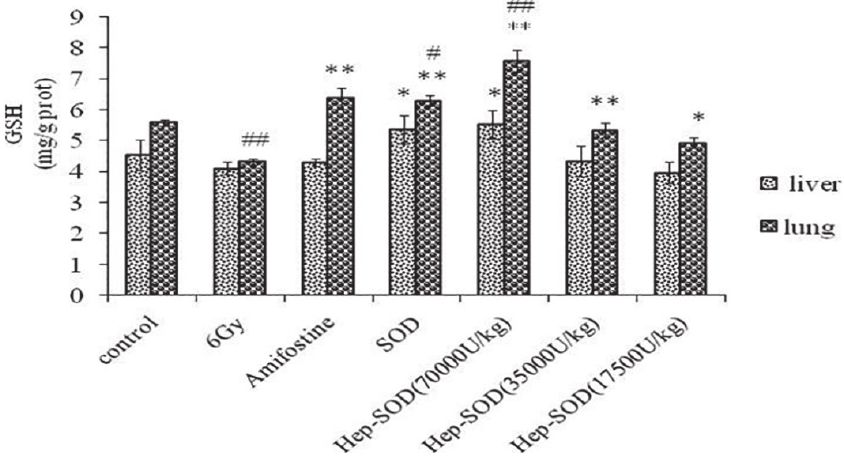
FIGURE 3 – GSH content in the liver and lung of irradiated mice in different groups. Notes: GSH content of 56 mice in different groups was detected, with eight mice in each group. * P < 0.05, ** P < 0.01, compared with the irradiated control group. # P < 0.05, ## P < 0.01, compared with the normal control group.